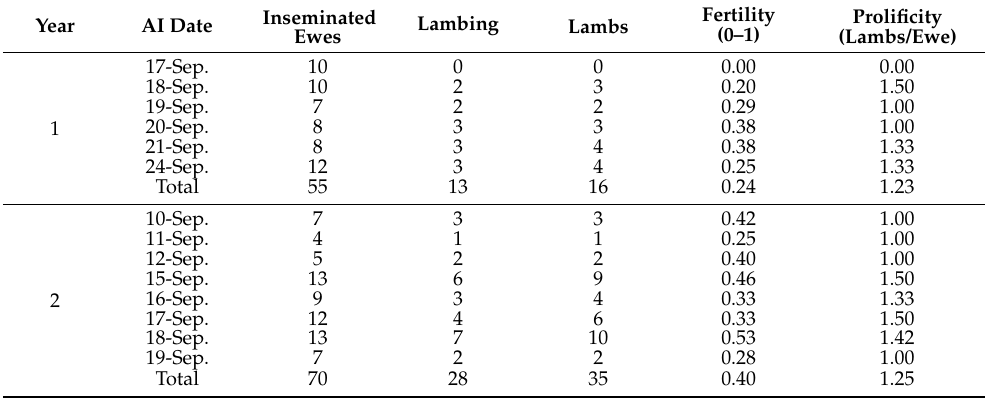
Table 1. Fertility and prolificity of inseminations in organic Churra ewes in the first two years of a 8-year study on a farm in